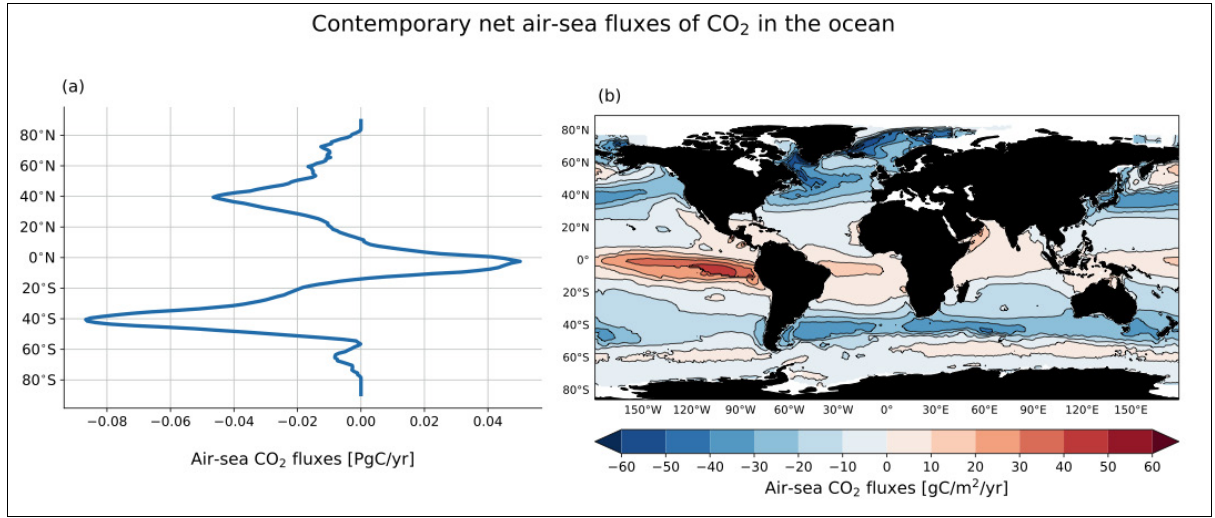
Source: Djeutchouang L, personal communication using the South African CSIR-ML6 machine learning model for global ocean CO Figure 4: Contemporary mean state of the global net ocean CO Ocean (south of 30°S) as a global ocean CO